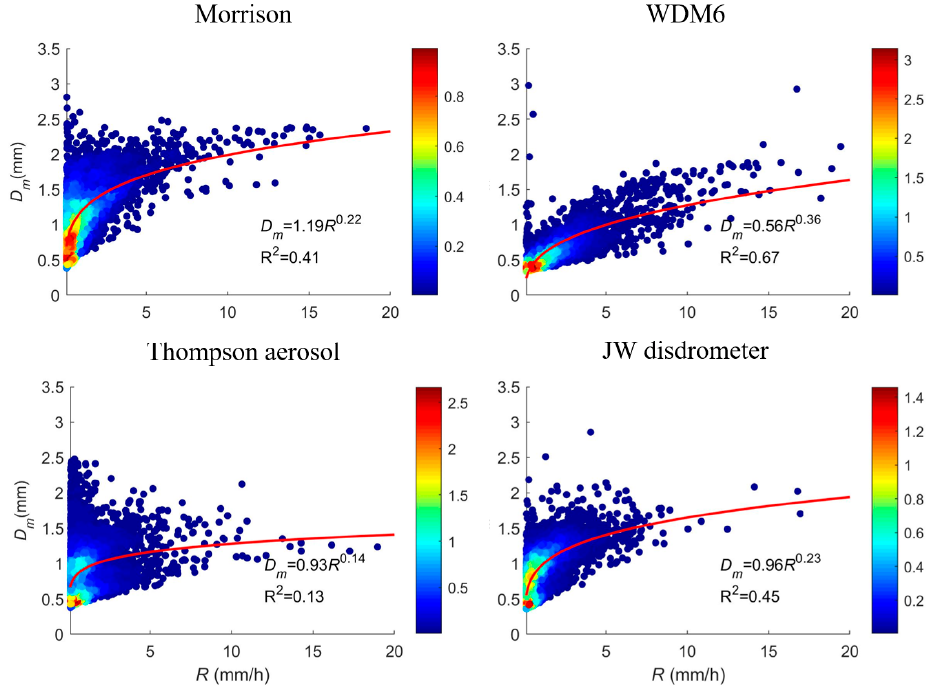
Figure 5. Density and fitting curves between D m and R of different double-moment schemes in the WRF model and JW disdrometer, and the corresponding R 2 values.